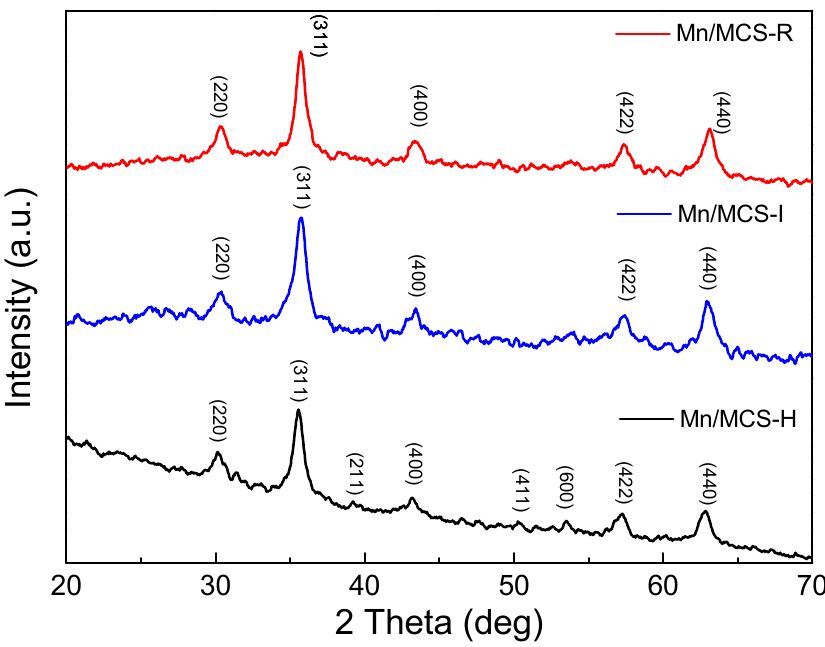
3 O 4 /C/Mn hybrids.